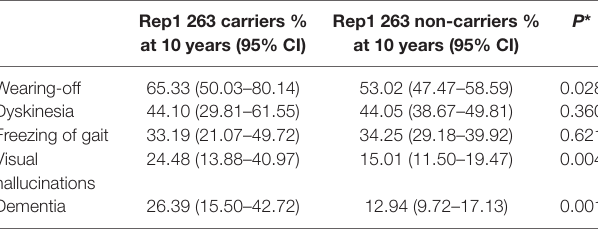
TaBle 2 | Probability of complications at 10 years from disease